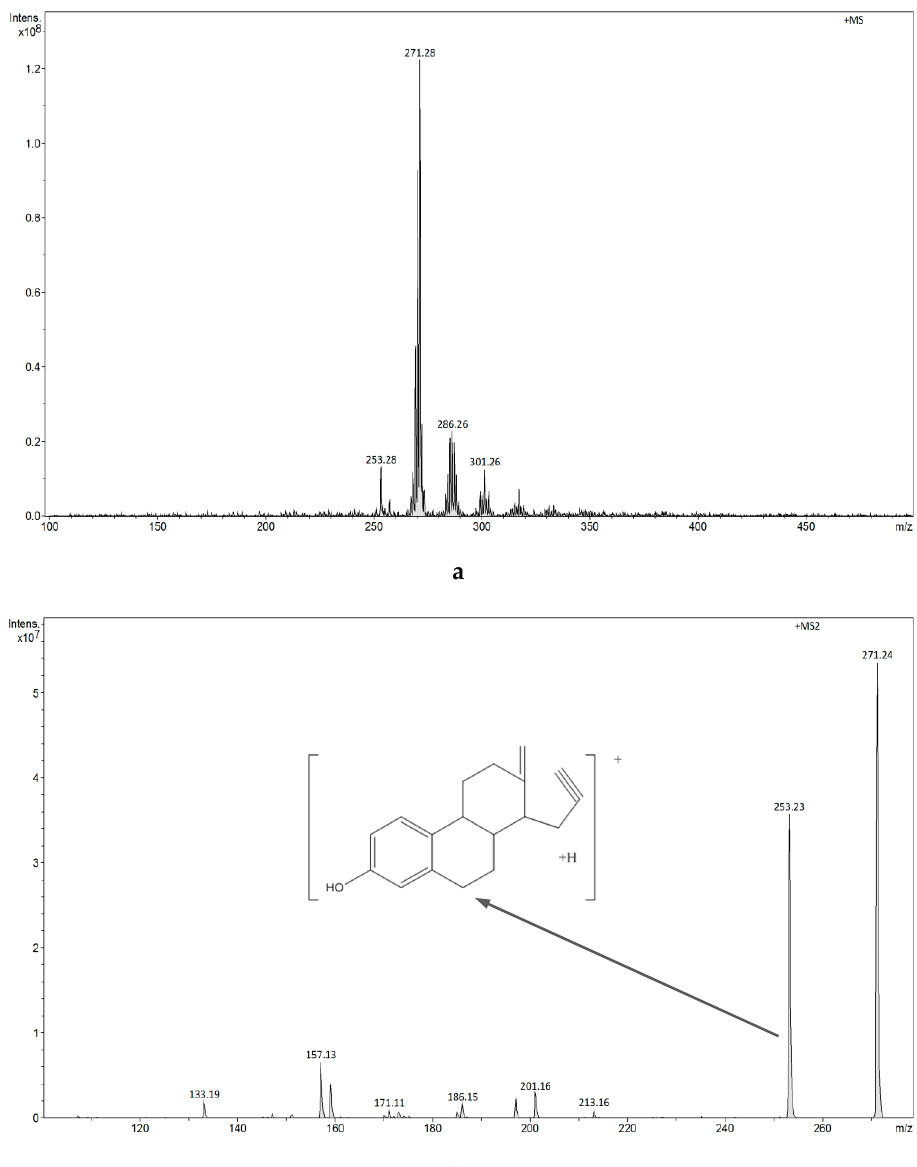
Figure 10. ( a ) FAPA-MS (positive ions) spectrum of E1. ( b )FAPA-MS 2 fragmentation spectrum of the m/z 271 ion observed for E1. m / z 271 ion observed for